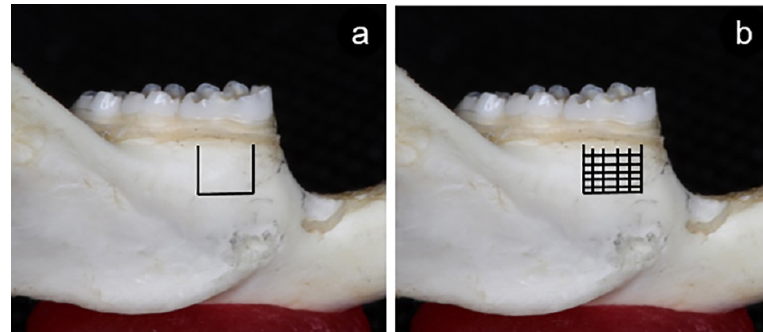
Figure 1- Schematic drawing of corticotomy(a) and decortication